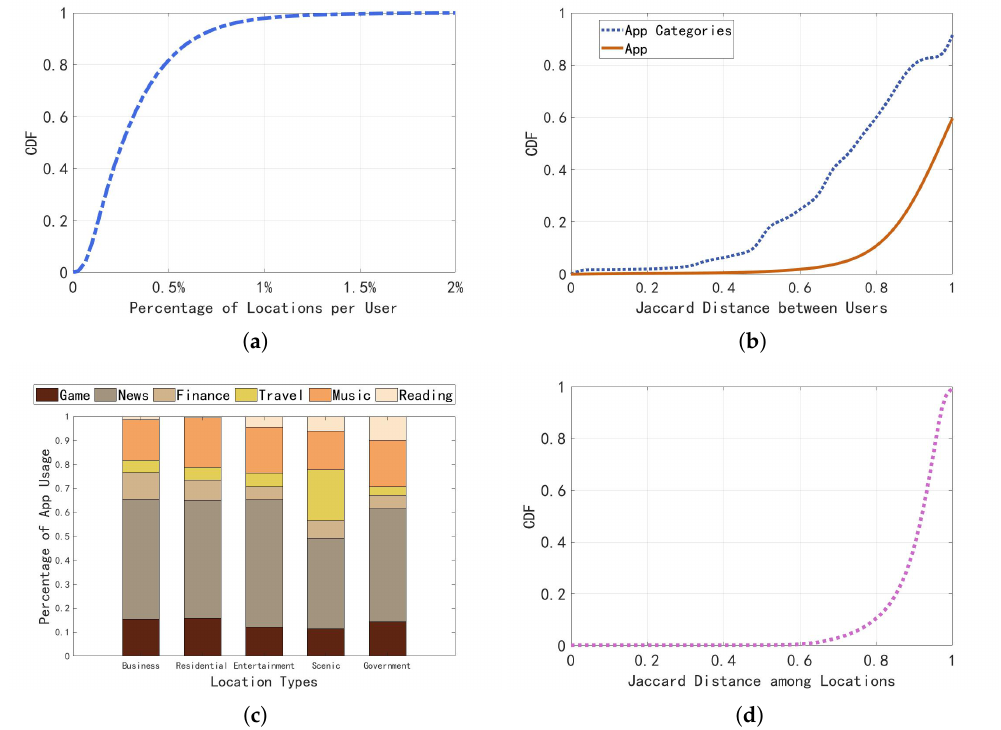
Figure 1. Illustration of statistics of Telecom dataset. ( a ) Number of locations per user. ( b ) App/app category differences. ( c ) App usage in different locations. ( d ) Location